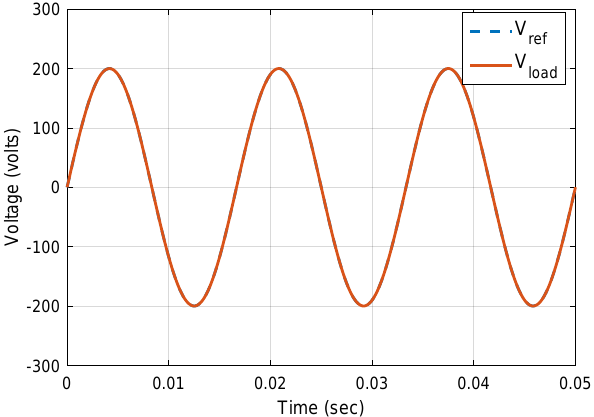
Figure 12. Time response of the independently-designed decentralized controllers for 1 (km) distance between the inverters.